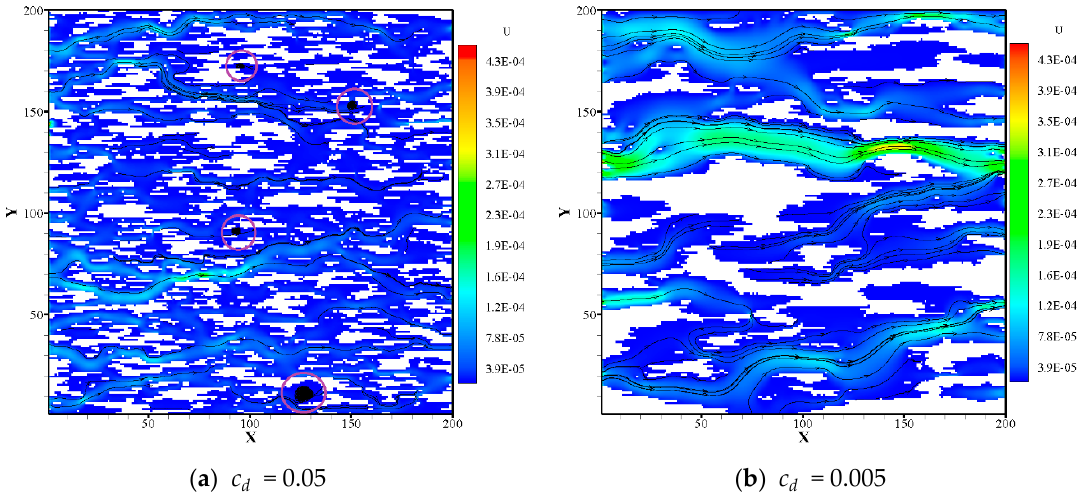
Figure 30. Streamline diagrams of quartet structure generation set with different growth core probabilities.